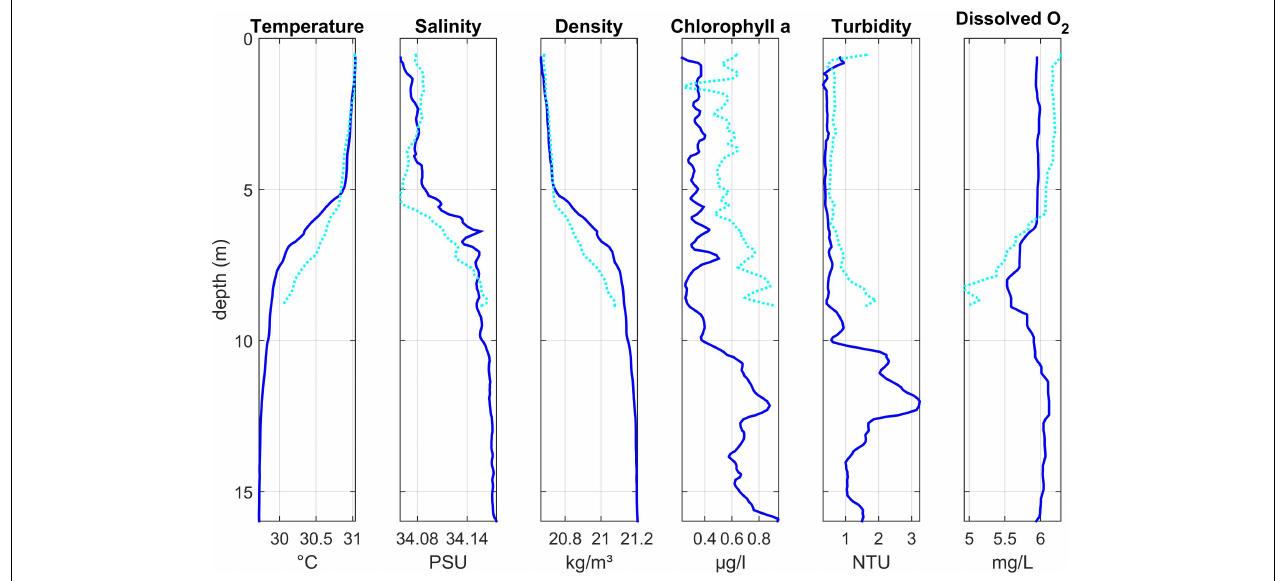
FIGURE 4 | Depth profiles of water column properties at two stations at the eastern edge of the lagoon (Region 3): Lagoon_11 (dark blue solid line) and Lagoon_12 (light blue dotted line). See Figure 1 for station locations.